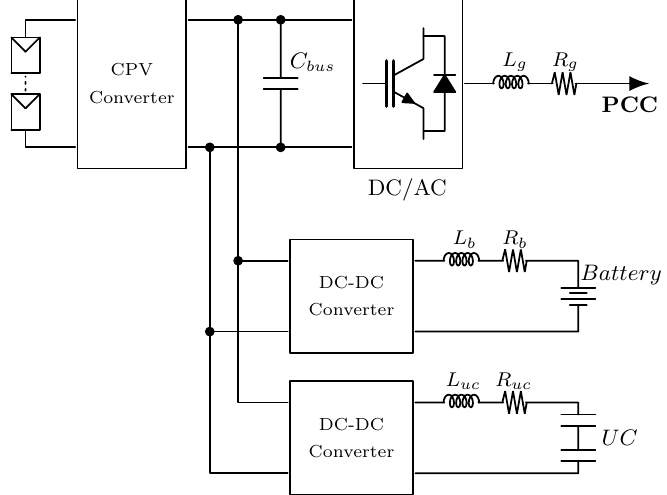
Figure 1. General structure of a concentration photovoltaic (CPV) tracker with hybrid energy storage system